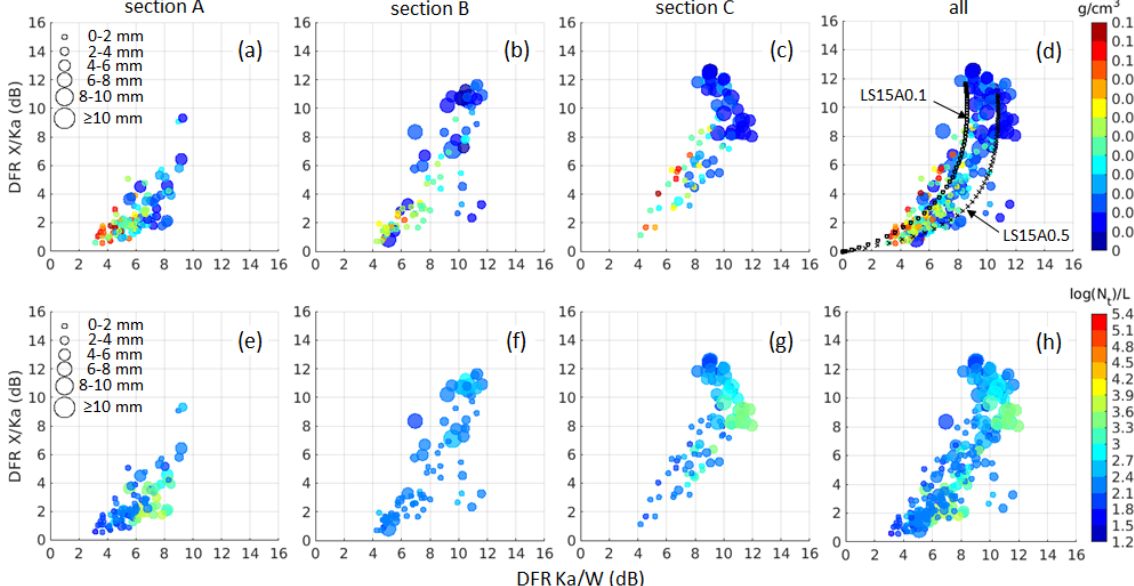
Figure 13. Similar to Fig. 11 but for flight segment 20:05–20:28UTC. In panel (d) , the black lines are for riming model A with effective liquid water paths of 0.1 and 0.5kgm − 2 (Leinonen and Szyrmer,